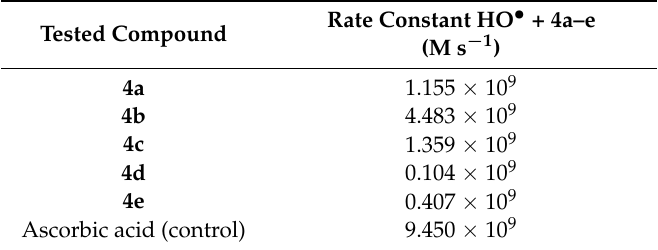
Table 3. The rate constants for the reaction.